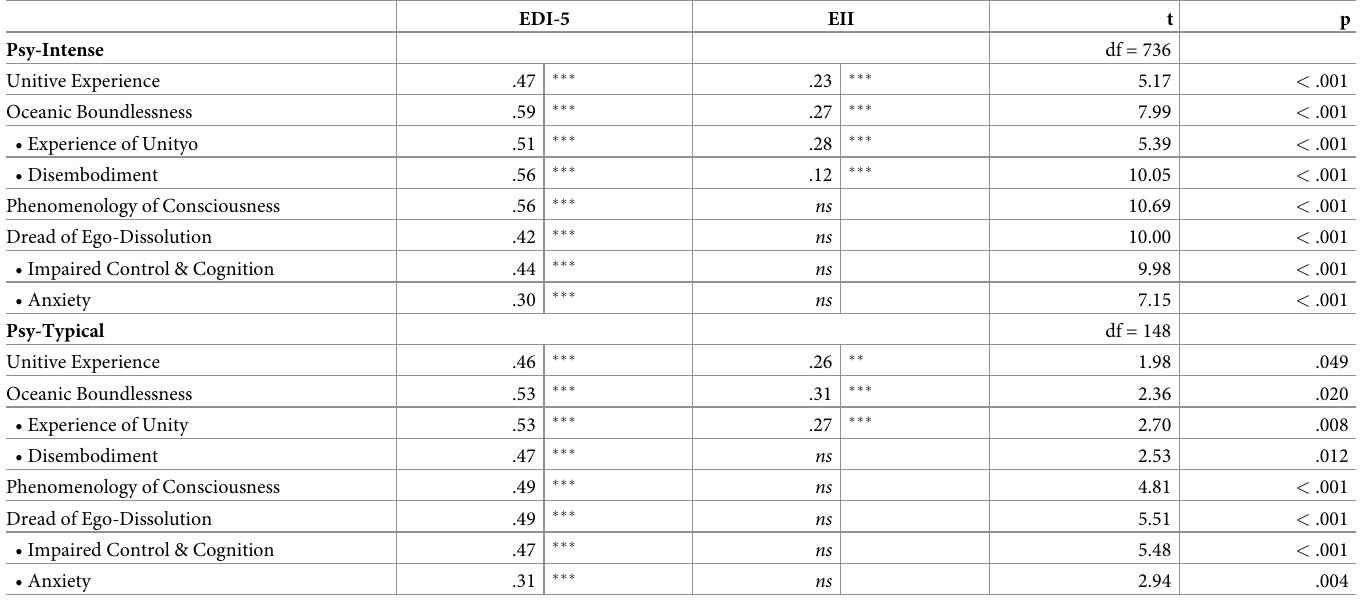
Table 6. Correlations (Spearman’s rho) examining relationships between the condensed ego-dissolution scale (EDI-5) and related ASC scales in comparison to the ego-inflation scale